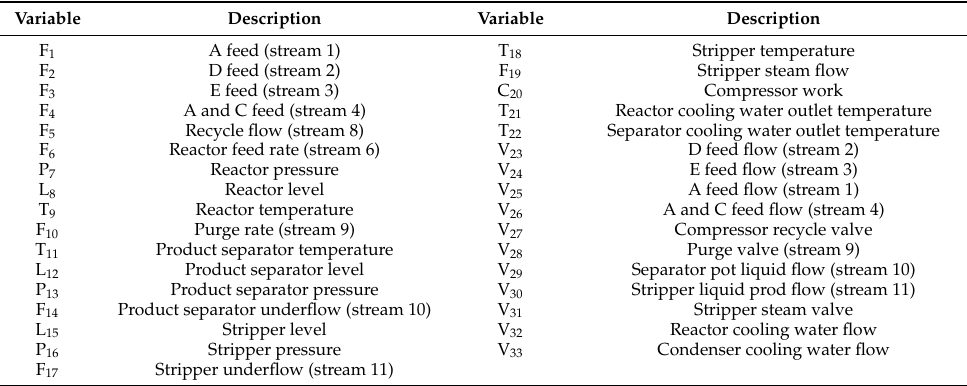
Figure 9. Tennessee Eastman process flow chart. Reproduced with permission from [Downs, J.; Vogel, E.], [Computers & Chemical Engineering]; published by [Elsevier], 1993. Table 1. The variables in the Tennessee Eastman process.